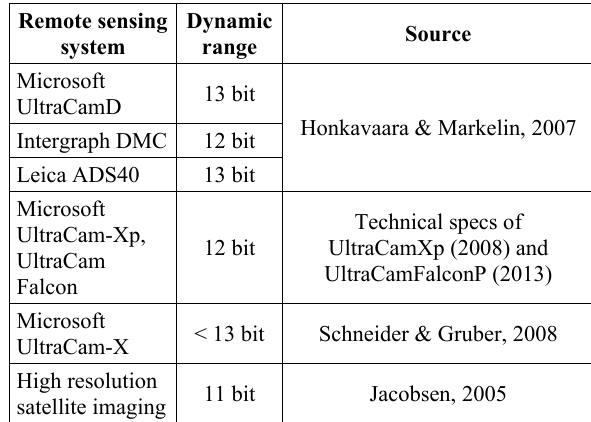
Table 2. Radiometric resolution of common remote sensing systems